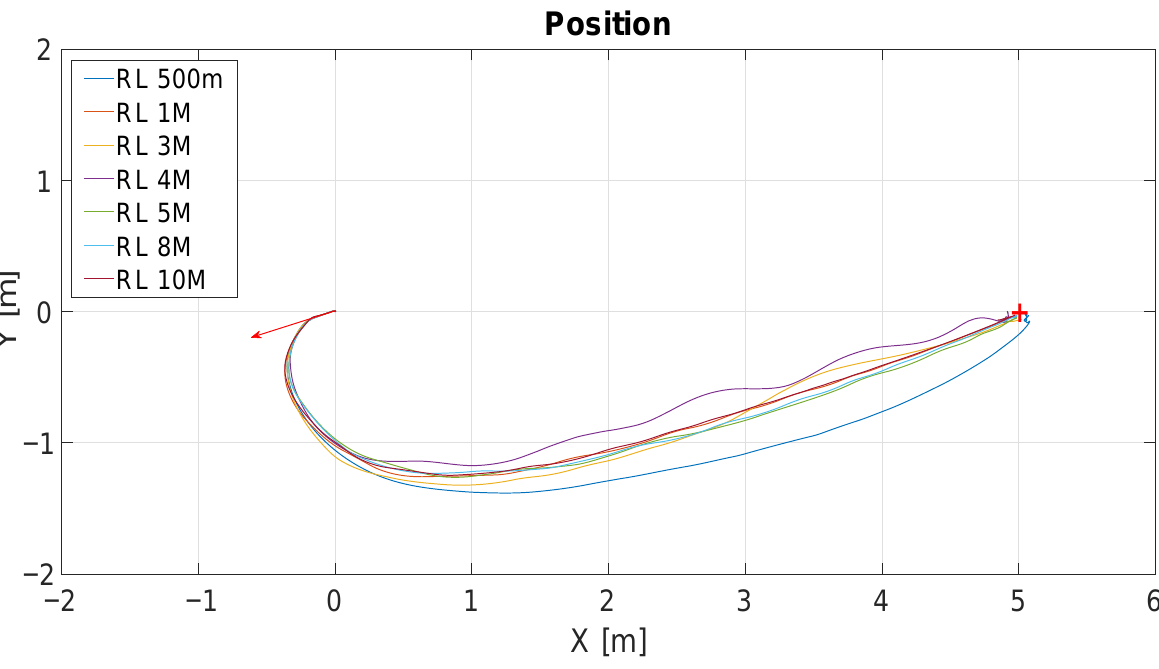
Figure 9. Obtained trajectories for different values of iteration in RL